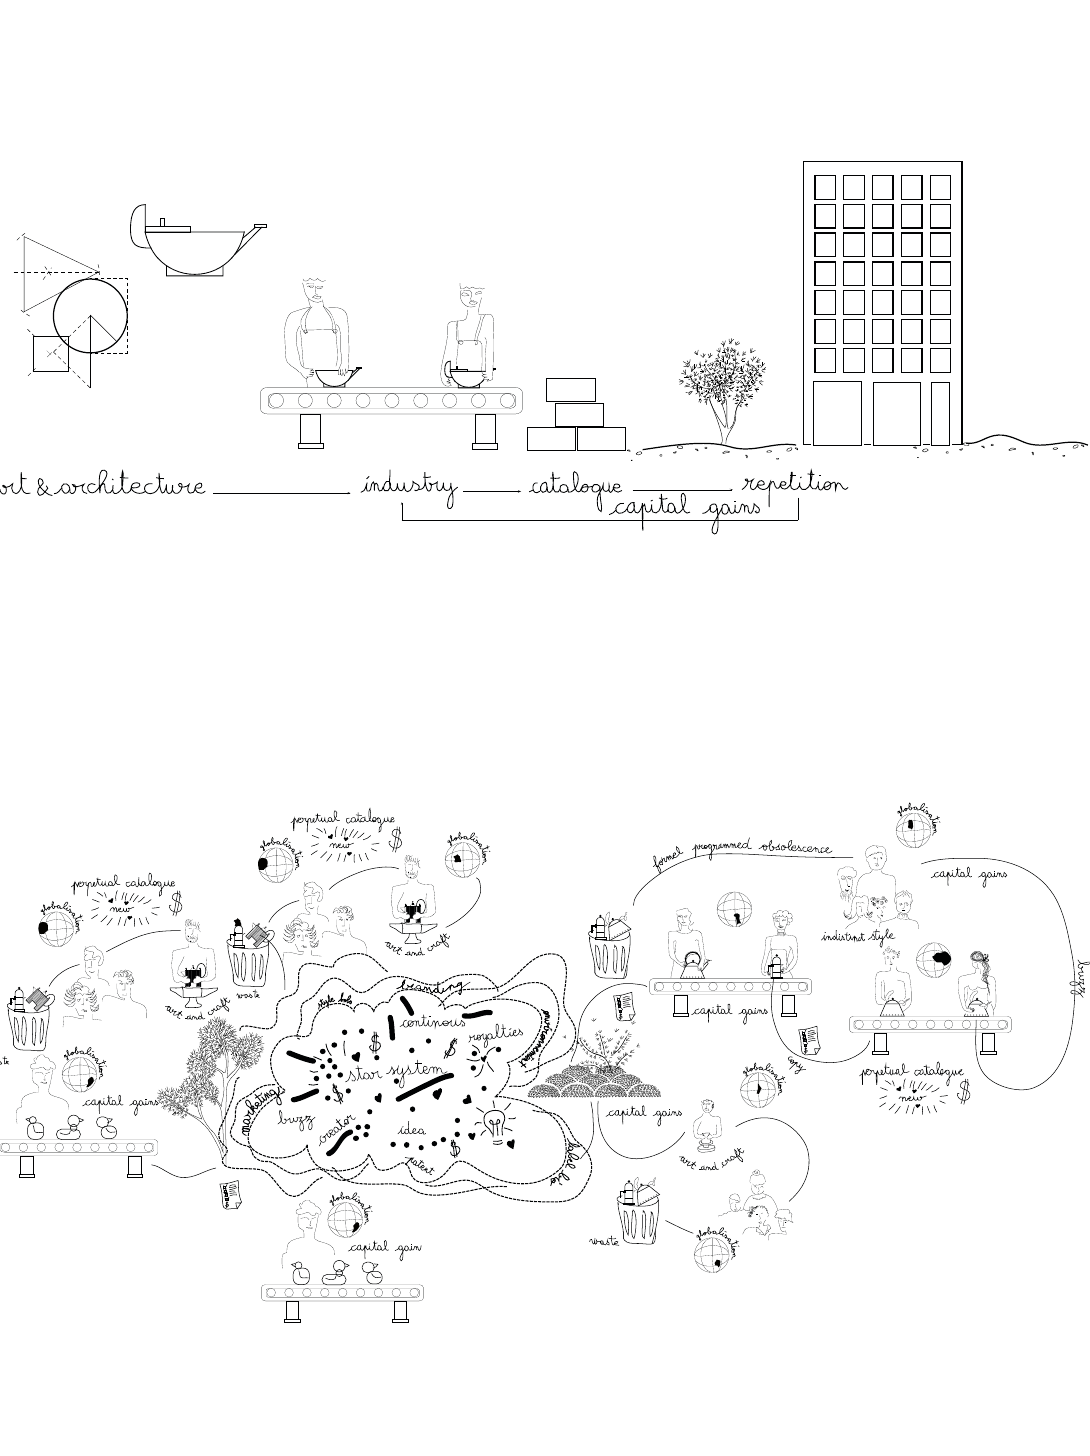
Figure 1: (top): Modernism. Source: Nathalie Bruyère. Figure 2 (bottom): Post-modernism. Source: Nathalie